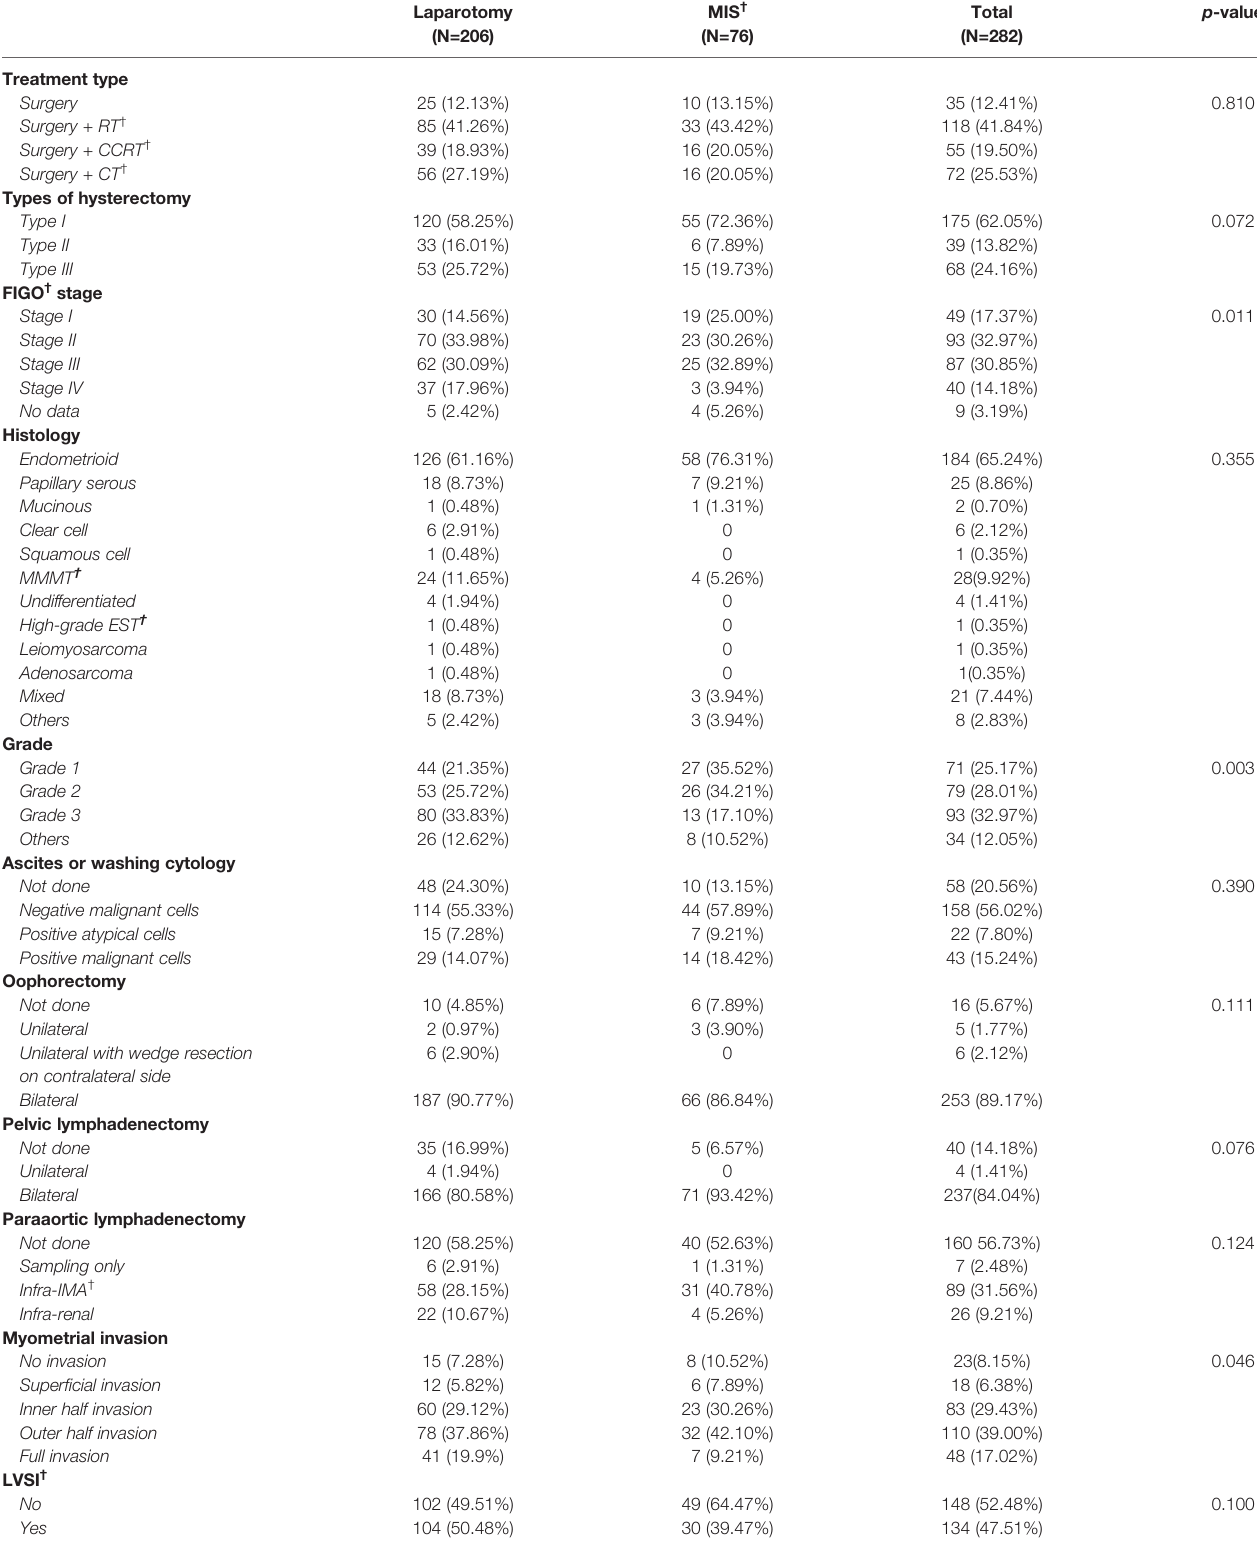
TABLE 2 | Pathologic fi ndings and adjuvant